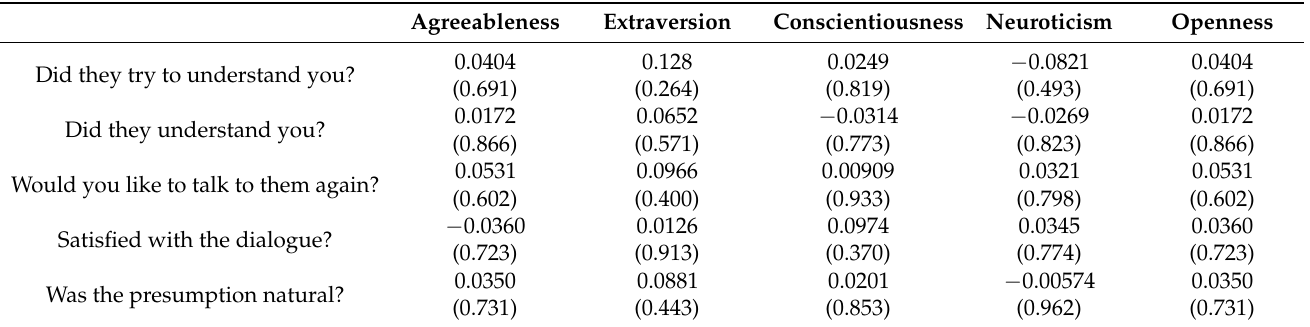
Table 10. Correlation coefficients between the percentage of correct answers for directly asked items and the questionnaire index.